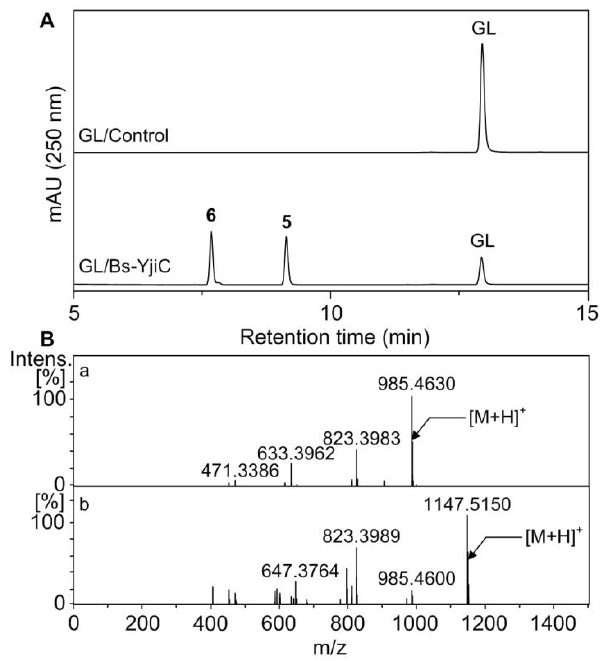
Figure 3. HPLC-ESI-MS analysis of the glycosylated products of GL. ( A ) HPLC chromatograms of Bs-YjiC-catalyzed reaction using GA as the aglycone. ( B ) MS spectra for products 5 (a) and 6 (b). 1 H NMR and 13 C NMR spectra of product 5 were highly similar to those of products 1 , 3 , and GL (Supplementary Information Figures S23 – S27) (Supplementary Information Table S5). 1 H NMR